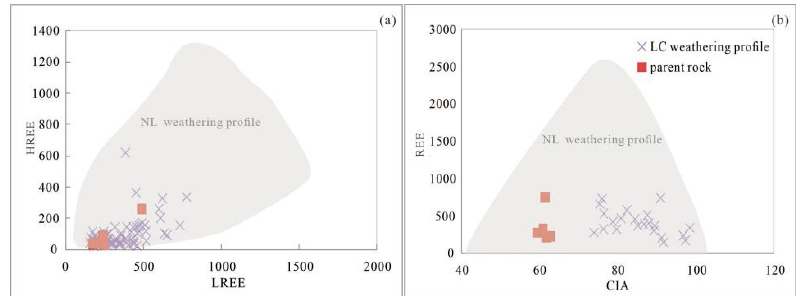
Fig.12 Diagrams of LREE-HREE (a) and CIA-REE of the Lincang granite and weathering profile Figure 12. Diagrams of LREE versus HREE ( a ) and CIA versus REE ( b ) of the LC granite and